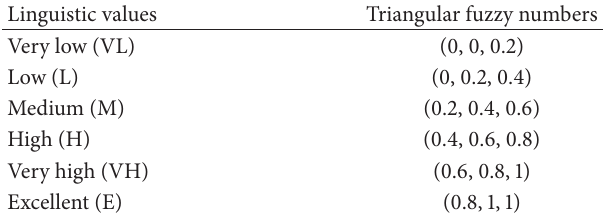
Table 2: Linguistic variables for the ratings.